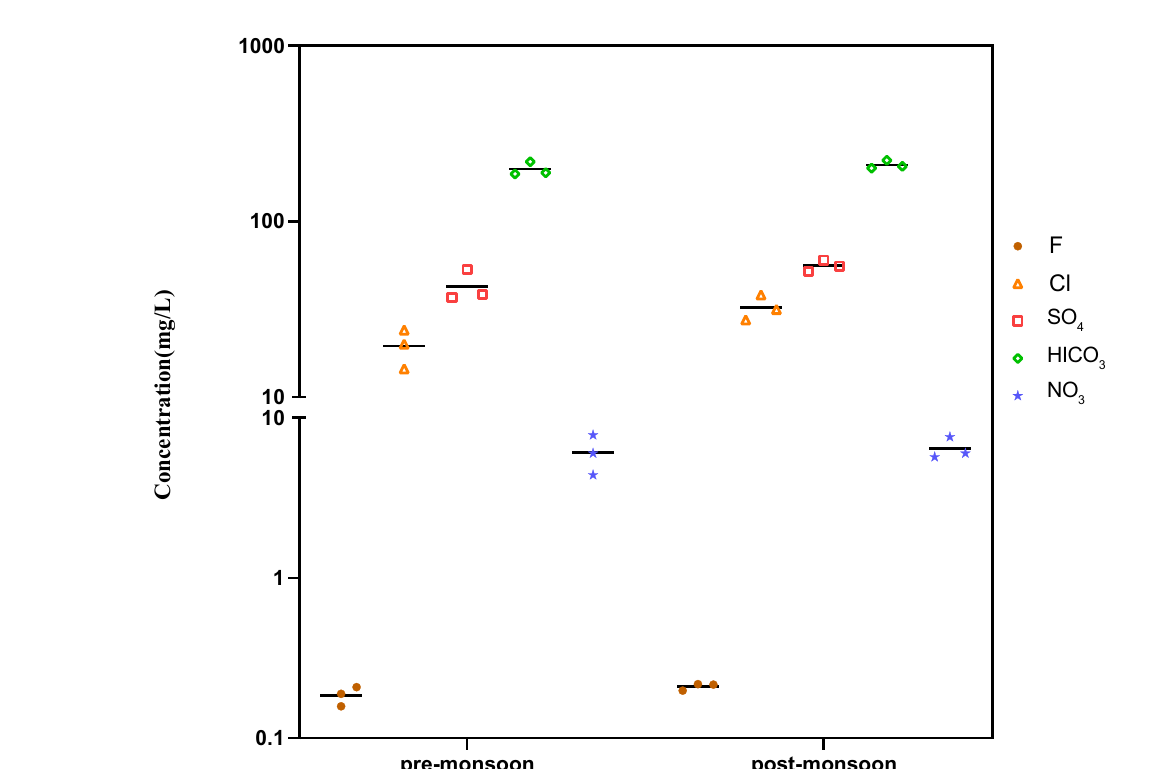
pre-monsoon Figure 2. Detected anions concentration in groundwater during pre- and Fig. 2. Detected anions concentration in groundwater during pre- and post-monsoon